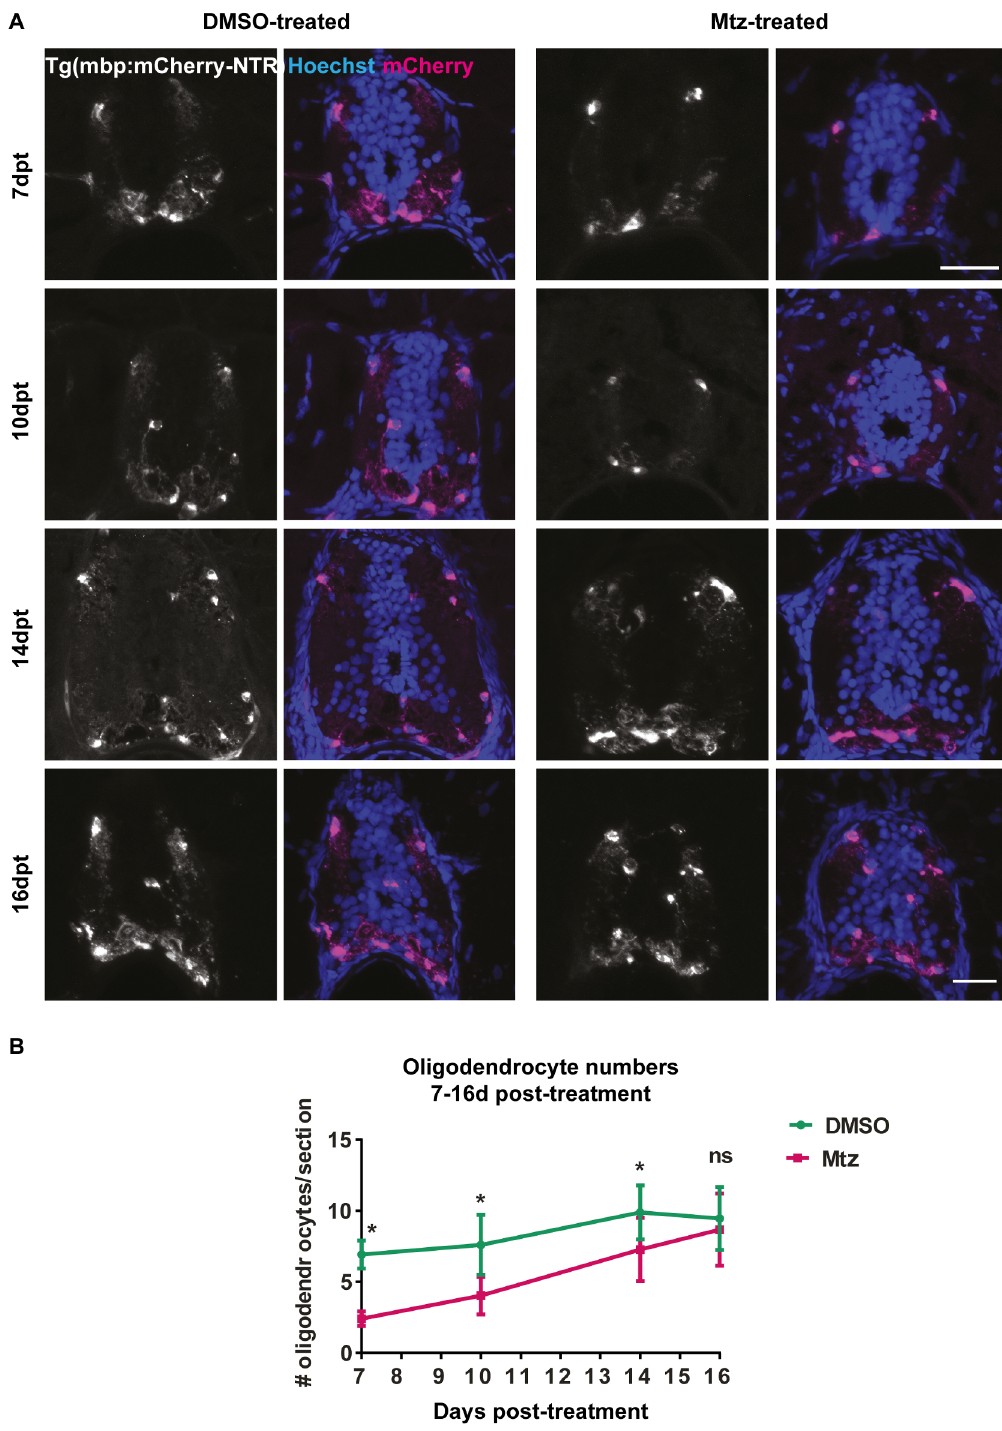
Fig 3. Oligodendrocyte numbers are restored to control levels by 16 days post-treatment. A. Representative images of transversely cut cryosectionsof spinal cords stained with Hoechst and showingendogenousexpression of the mbp:mCherry-NTR transgene. Time points from 7d post-treatment to 16d post-treatment are shown, as indicated. Yellow arrowheads point to examplesof doublepositive cells that were countedas oligodendrocytes. B . Quantification of oligodendrocyte numbers per section. At 7dpt, mean in controls: 6.9 ± 0.44 vs treated: 2.4 ± 0.23 in Mtz-treated sections, p < 0.0001. At 10dpt, controls: 7.6 ± 0.75 vs treated: 4.04 ± 0.47, p = 0.0012. At 14dpt, controls: